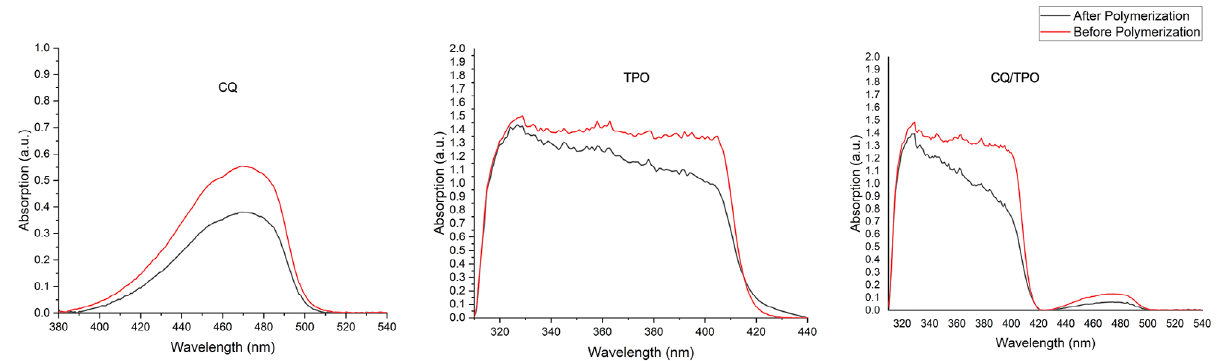
Figure 3- Absorbance (L mol – 1 cm – 1) x wavelength (nm) for each solution before and after